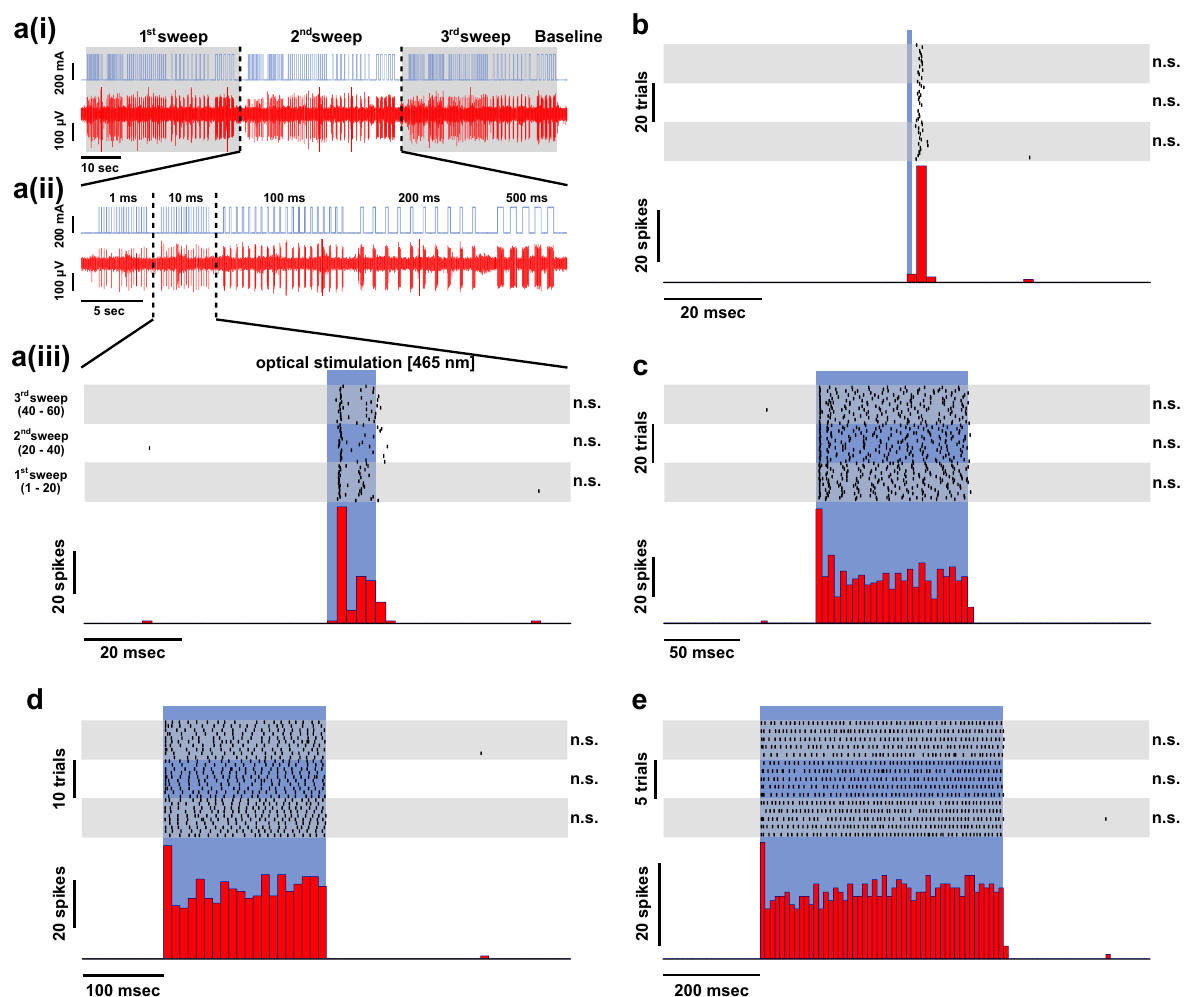
Fig. 5 Single-cell responses upon optical stimulation (Cell 4). a(i) Stimulation protocol (upper trace) and the resulting evoked cellular responses (lower trace). The stimulation protocol consisted of repeated light pulses of different durations (1, 10, 100, 200, and 500 ms) and was repeated three times (sweep 1 – 3, indicated by the gray/white background). The baseline- fi ring rate of each neuron was assessed before/after the light stimulation protocol. a(ii) A single sweep (i.e., sweep 2) of the optical stimulation protocol. The 10 ms optical stimulation is highlighted and further analyzed in (a(iii)) . Raster plot (upper part) and peri-stimulus time histogram (PSTH; lower part) of the cell response. The raster plot characterizes the cellular response aligned with the onset of the optical stimulation (465 nm at 300 mA; blue shaded area). Each line represents one optical stimulation. Each dot within that line represents an evoked action potential. For each repetition of the stimulation, a new line is added to the plot. The gray/white background of the raster plot indicates the blocks of repetition (sweep 1 – 3). To assess the variability of the evoked responses, the sweeps were statistically compared. In the case of this cell, no statistical differences were found (indicated by the abbreviation n.s. next to the raster plots). The PSTH represents the summed responses within a certain time window (bin). In case of the 10 ms stimulus presentation, the bin width is 2 ms. b Raster plot (upper trace) and PSTH (lower trace) for the 1 ms stimulus duration (bin width: 2 ms). c Raster plot (upper trace) and PSTH (lower trace) for the 100 ms stimulus duration (bin width: 4 ms). d Raster plot (upper trace) and PSTH (lower trace) for the 200 ms stimulus duration (bin width: 10 ms). e Raster plot (upper trace) and PSTH (lower trace) for the 500 ms stimulus duration (bin width: 10